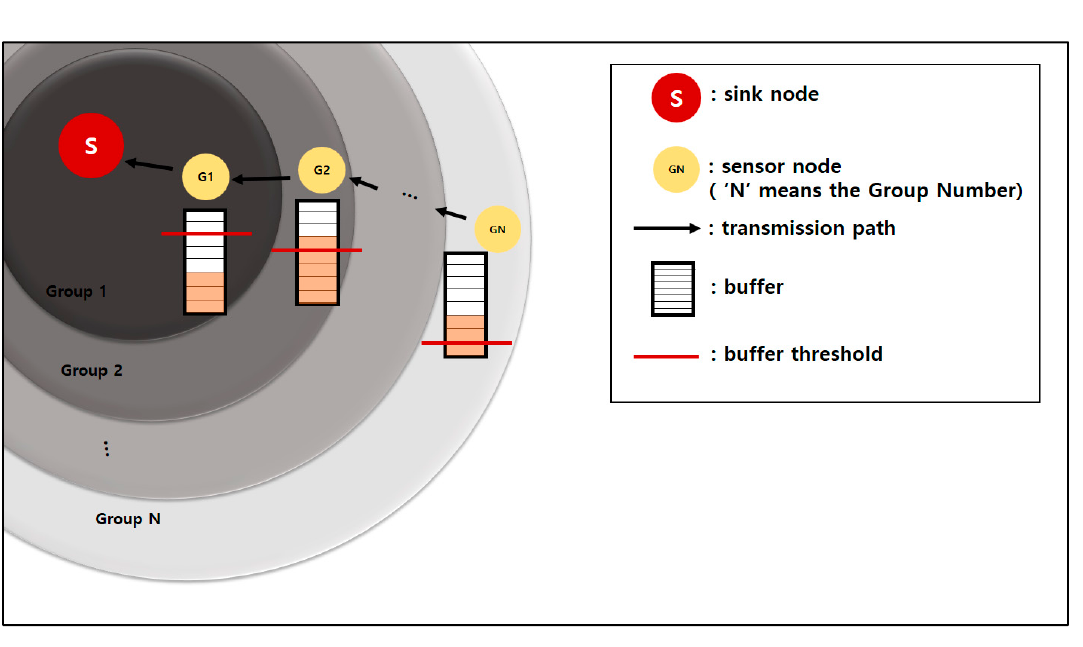
Figure 5. Buffer thresholds for node groups. Figure 5. Bu ff er thresholds for node